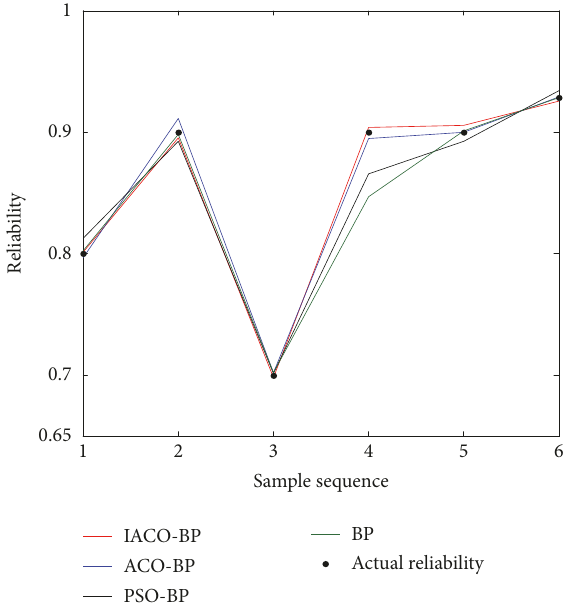
Figure 7: Reliability prediction curves of four